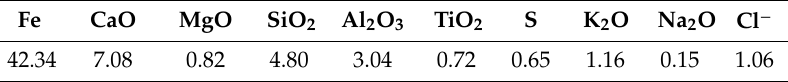
Table 2. Composition of dust ash from roasted iron ore.